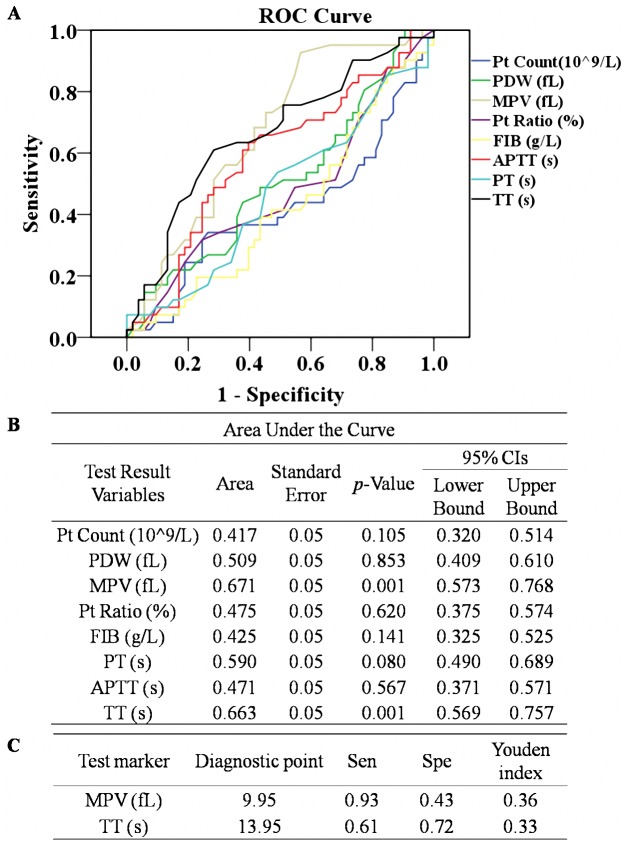
ROC curves for APTT, FIB, TT, PT, Pt Count, PDW, MPV and Pt Ratio in early pregnancy to analyze the optimal diagnostic points for predicting the severity of PE.